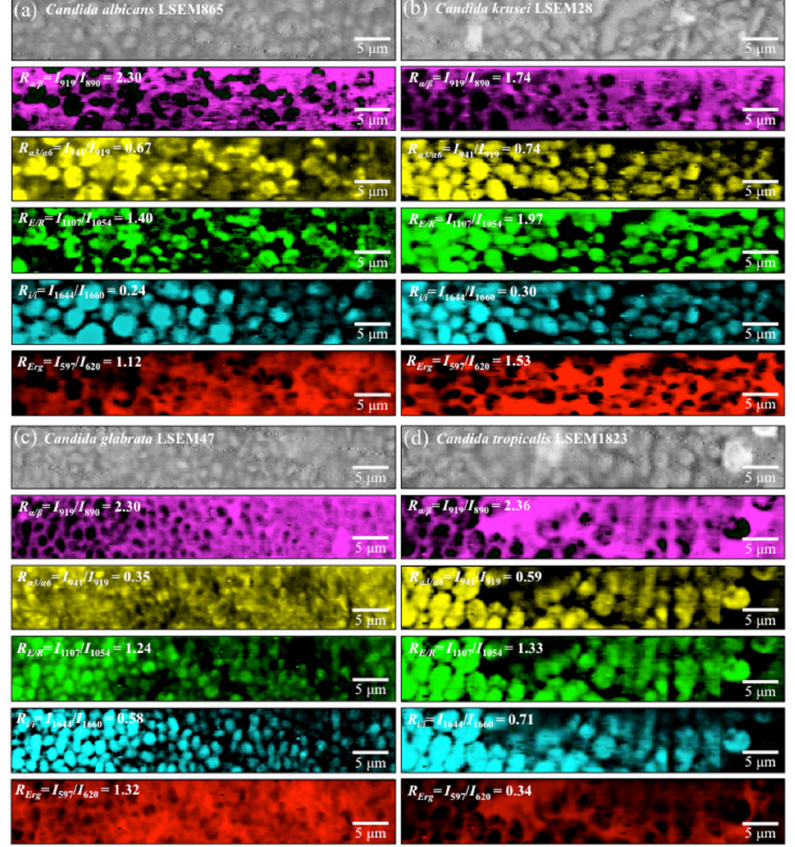
Figure 9. Raman maps of the five selected parameters R α / β = I 919 / I 890 , R α 3 / α 6 = I 941 / I 919 , R E/R = I 1107 / I 1054 , R i/I = I 1644 / I 1660 , and R Erg = I 597 / I 620 for ( a ) C. albicans , ( b ) C. krusei , ( c ) C. glabrata , and ( d ) C. tropicalis